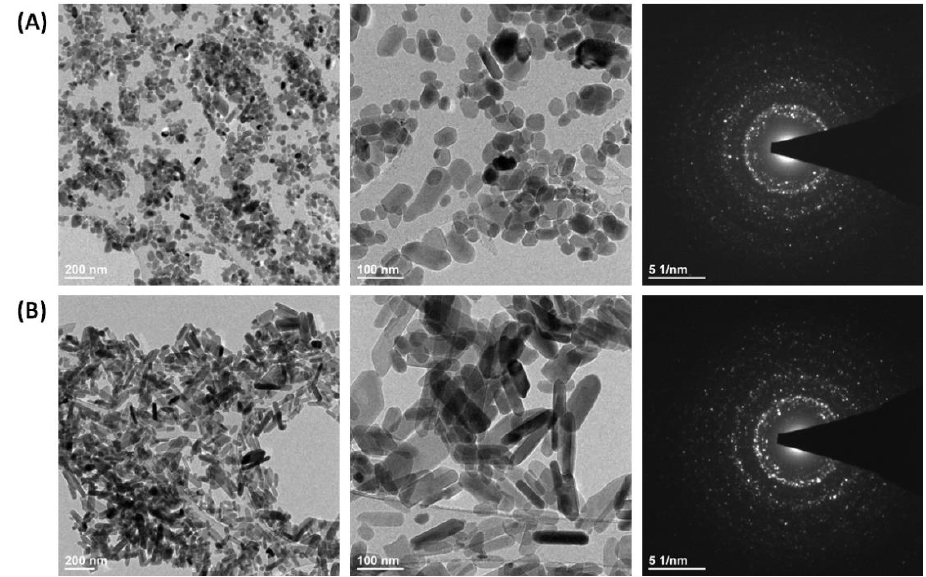
Figure 4. TEM images and SAED images of ( A ) Ca 9.8 Eu 0.1 Rb 0.1 (PO 4 ) 6 (OH) 2 ( B ) Ca 9.7 Eu 0.1 Rb 0.2 (PO 4 ) 6 (OH) 2 .